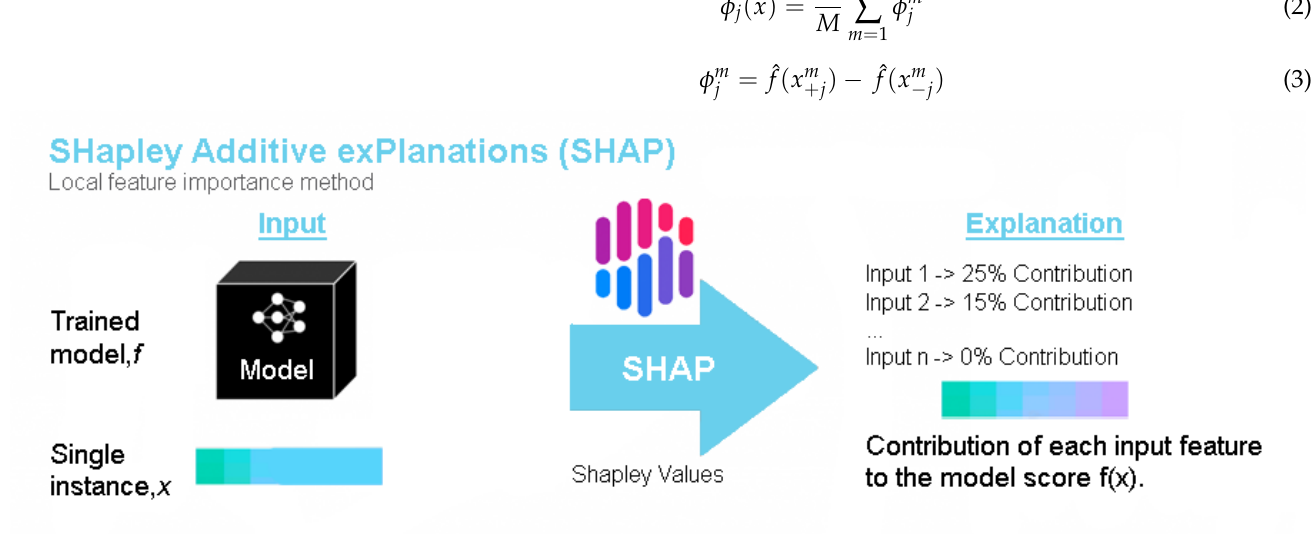
Figure 4. Pipeline of post hoc explainable tool